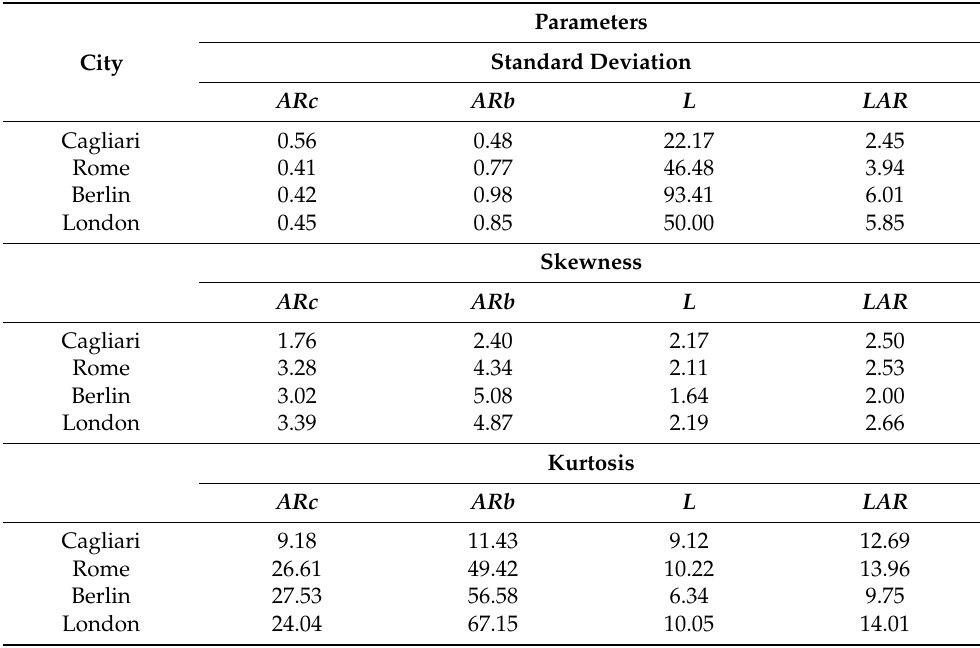
Table 4. Summary of main central moments indexes for statistic samples analysed (standard devia- tion, skewness and kurtosis) for each parameter and case